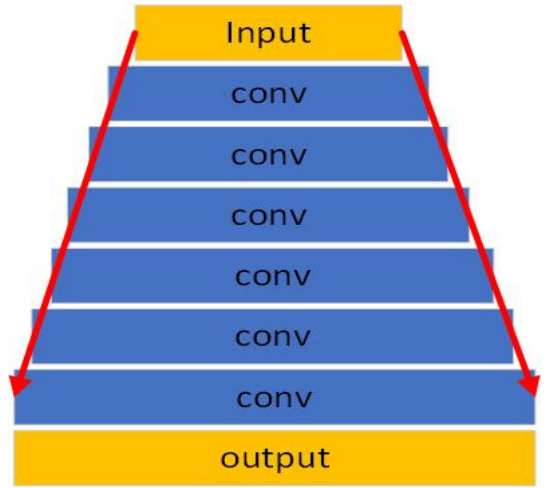
Figure 2. Pyramidal Net.